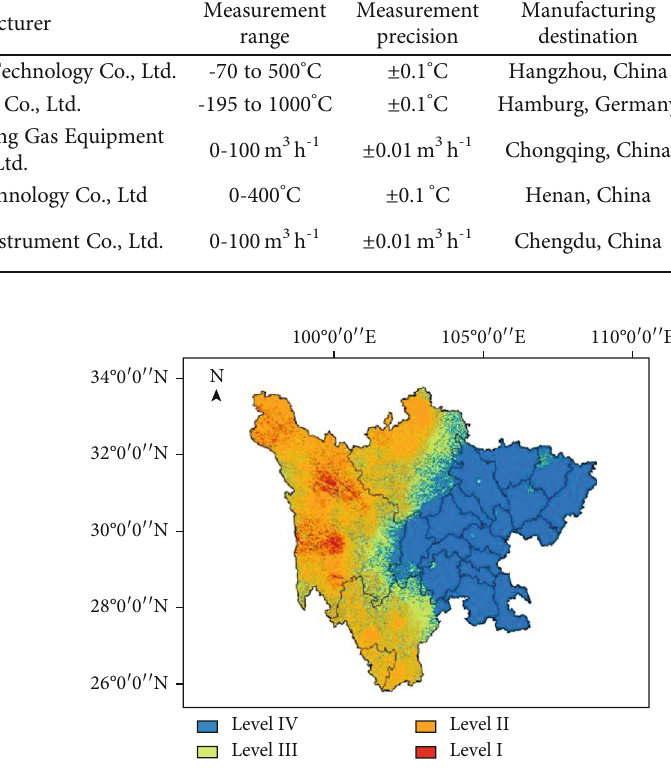
Figure 5: Distribution of solar energy richness in Sichuan